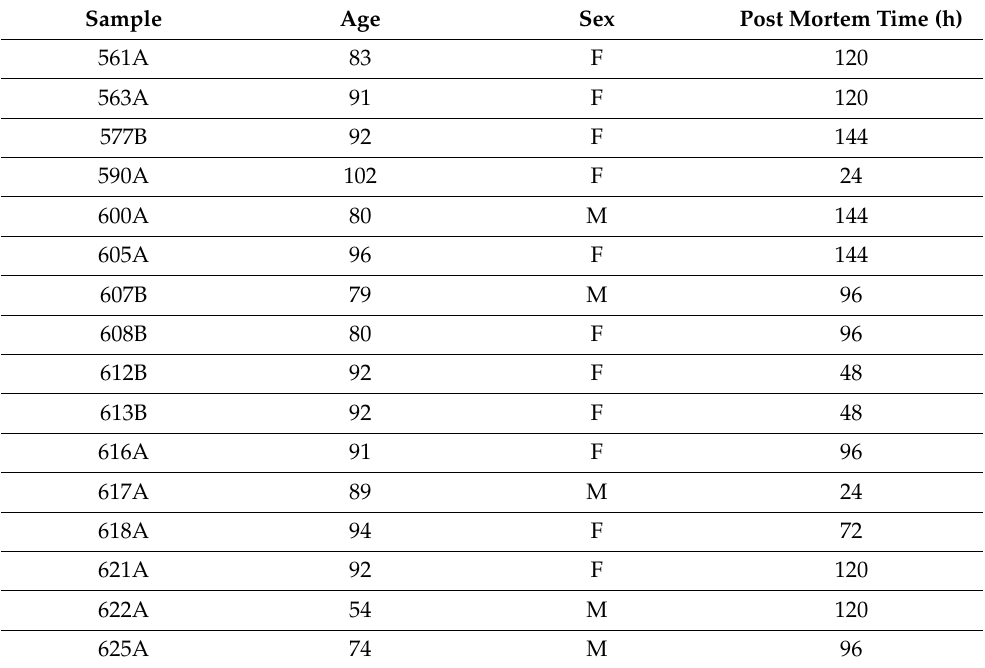
Table 5. Tissue donor information. Median age 91 years old, Range 54–102. Median post mortem time 96 h, Range